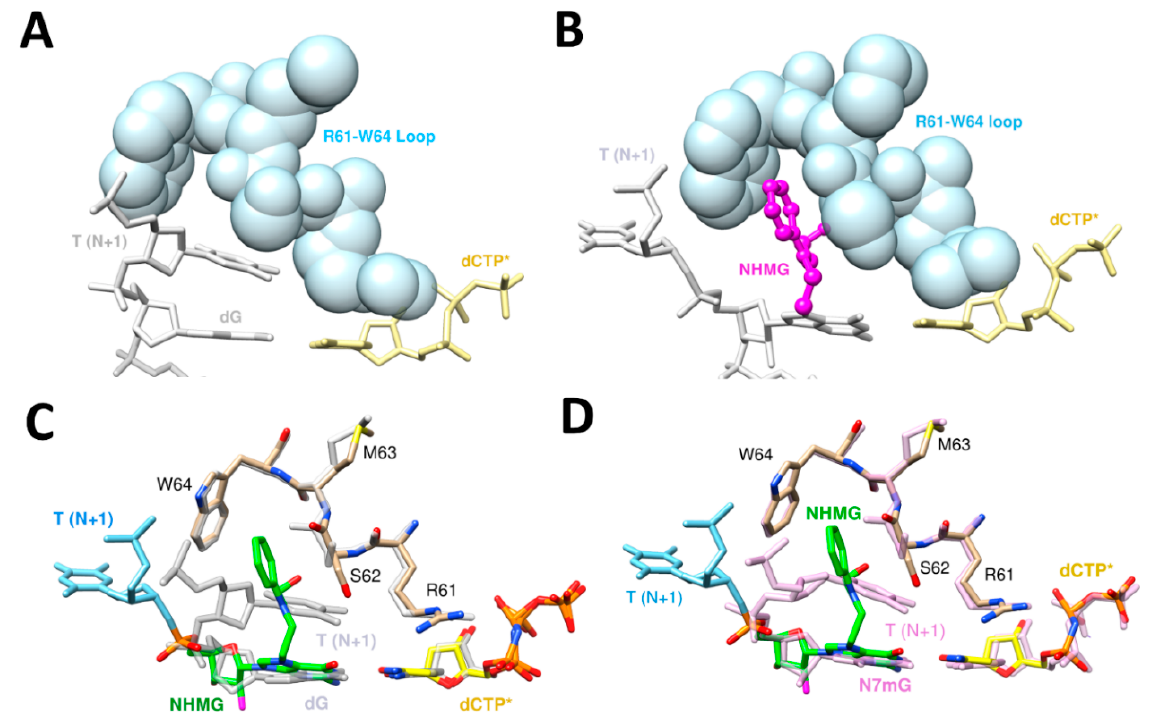
Figure 3. The structure comparison between NHMG (PDB ID: 6V5K) and undamaged dG (PDB ID: